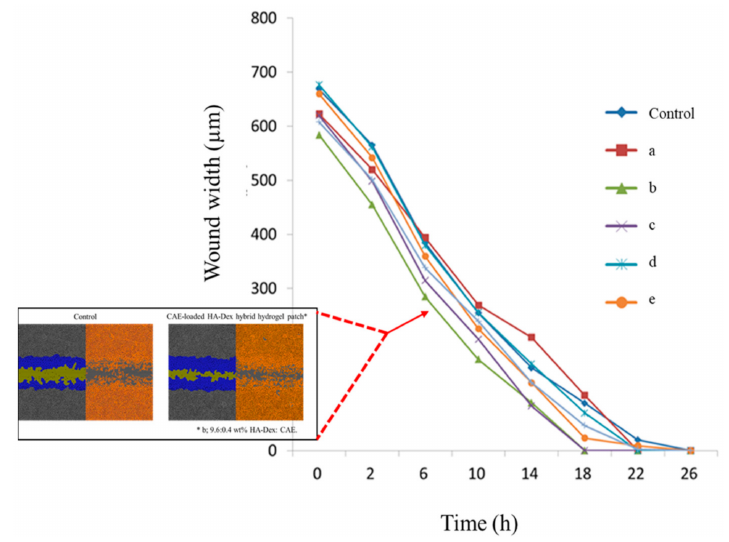
Figure 9. Wound closures rates for Centella asiatica extract (CAE)-loaded hyaluronic acid-dextran (HA-Dex) hybrid hydrogel patches. (a) 9.8:0.2, (b) 9.6:0.4, (c) 9.4:0.6, (d) 9.2:0.8, and (e) 9:1 wt% HA-Dex: